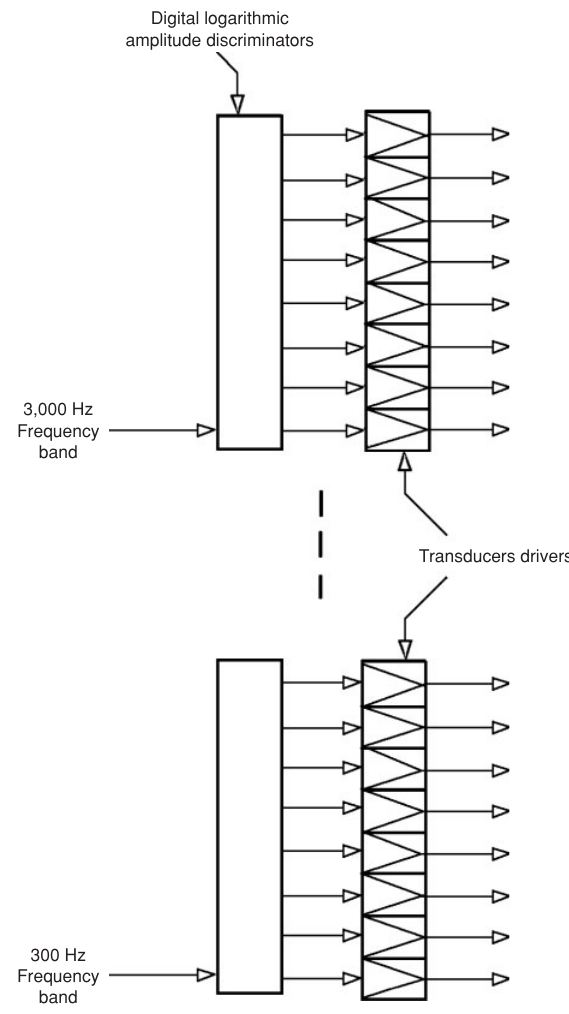
Figure 3 Tactile driver